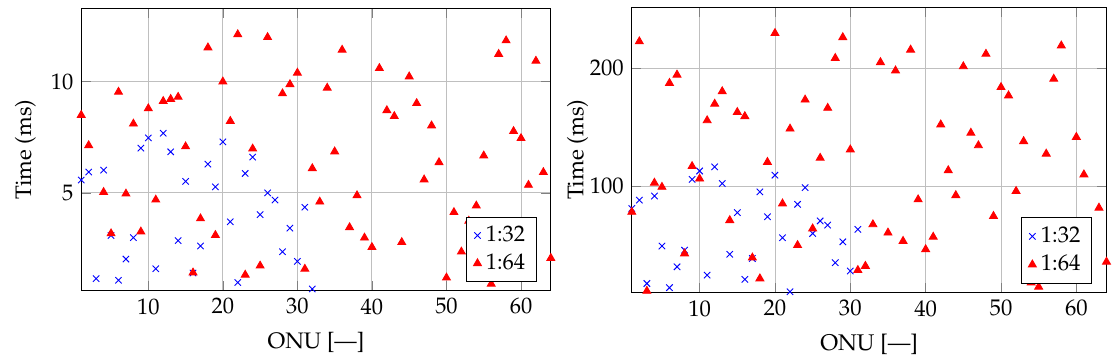
Figure 7. Graph of activation time for EPON ( left ) and GPON ( right ) 32/64 units and 20-km Figure 2. Graph of activation time for EPON 32/64 units and 20 km ODN. Figure 3. Graph of activation time for GPON 32/64 units and 20 km ODN.